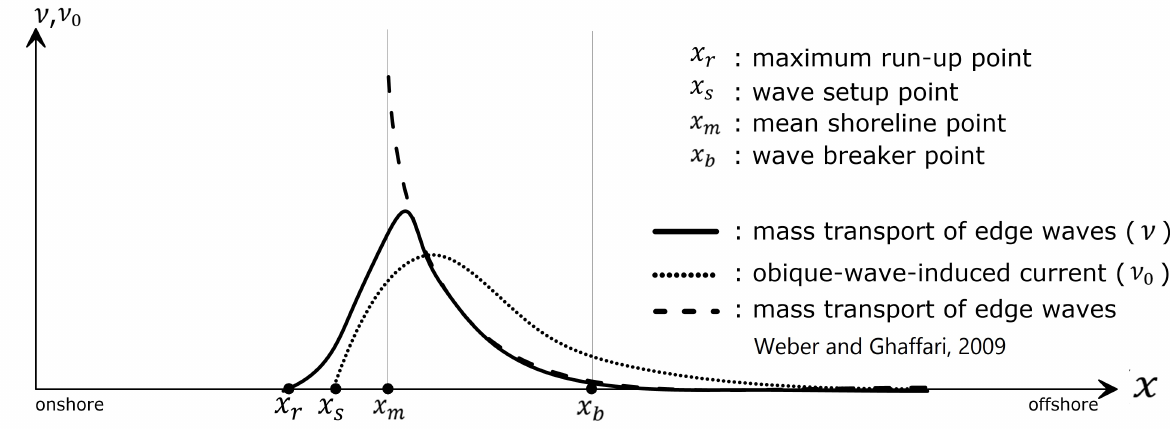
Figure 8. Concept of edge wave mass transport and oblique wave-induced current distribution